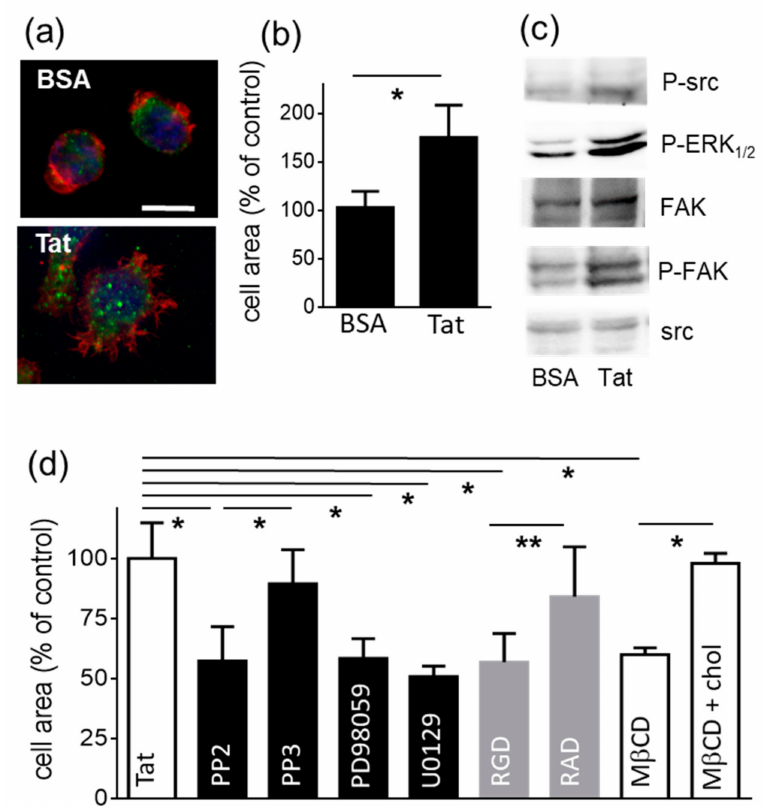
Figure 1. Substrate-immobilized Tat induces SYN-NC spreading. ( a ) Representative micropho- tographs of SYN-NCs adherent to BSA or to Tat immunostained for actin (red), paxillin (green) and nuclei (blue) (scale bar 5 µ m). ( b ) SYN-NC area measured in Tat-adherent cells expressed as mean percentage ± S.E.M. in respect to the area of BSA-adherent cells. * p < 0.0001, Student t -test. ( c ) Tat-adherent SYN-NCs were analyzed in WB. The intensity of each band was normalized with respect to the corresponding control protein. The statistical significance of Tat-dependent activation was then calculated and reported in Table S1. ( d ) The area of SYN-NCs was measured in 30 to 50 cells, which were allowed to adhere and spread onto Tat in the presence of the indicated inhibitors